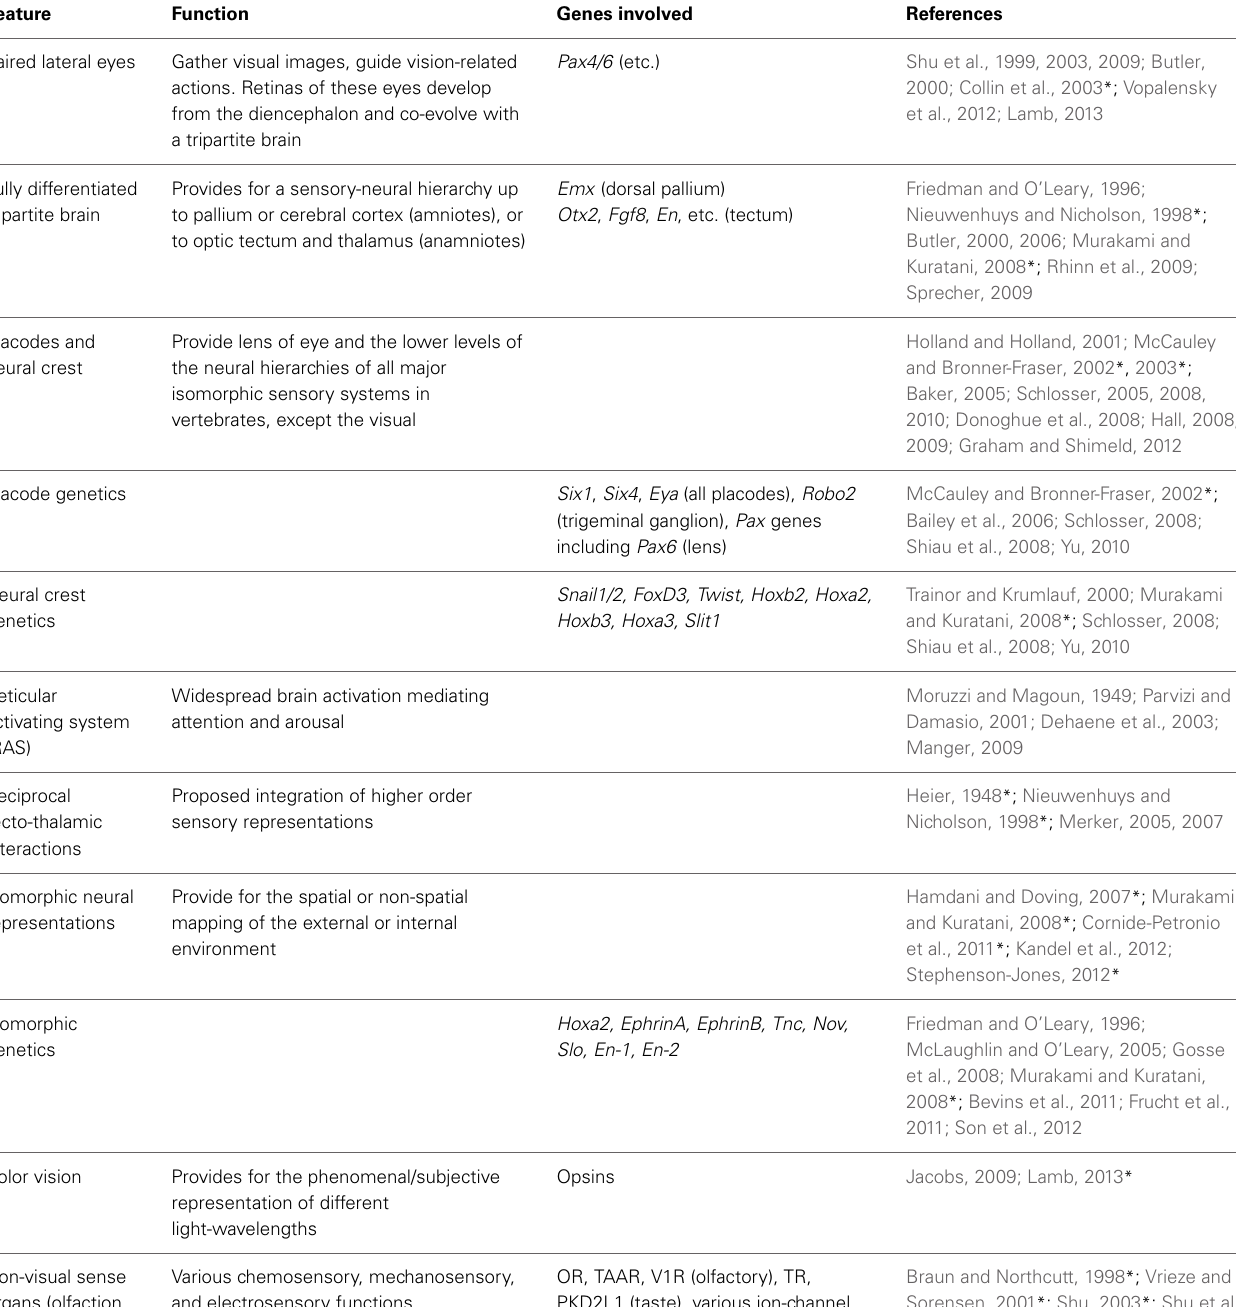
Table 2 | Neural features, functions, and genes proposed to contribute to consciousness in vertebrates.